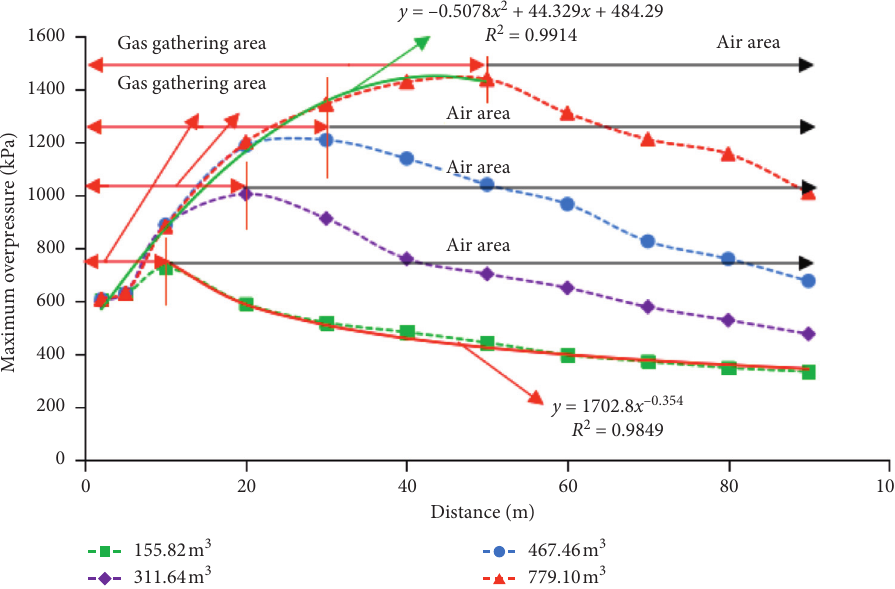
Figure 10: Distribution law of overpressure on driving surface ( X � 2.45m, Y � 1.6m).